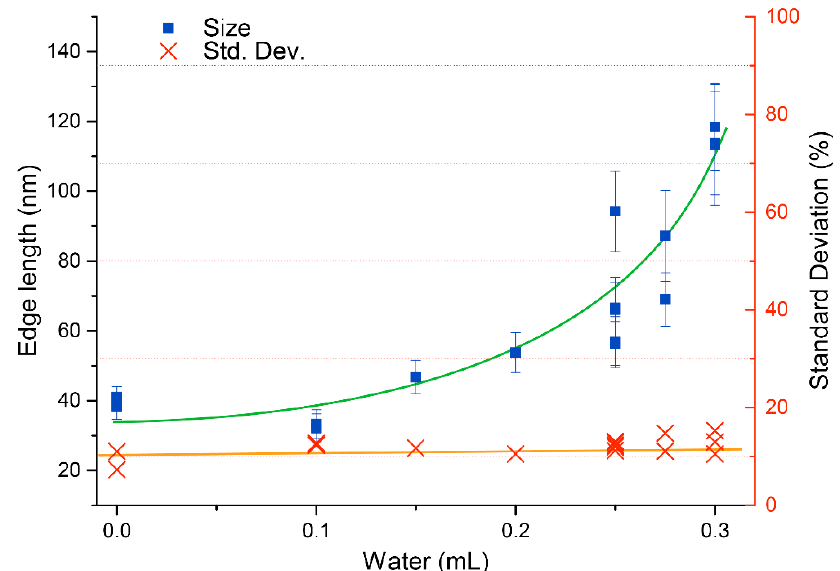
Figure 4. Size of Cu 2 O nanocubes synthesized with varying amounts of added water. The graph shows that the final particles size increases with increasing amount of added water. The green and orange curves are to guide the eye.